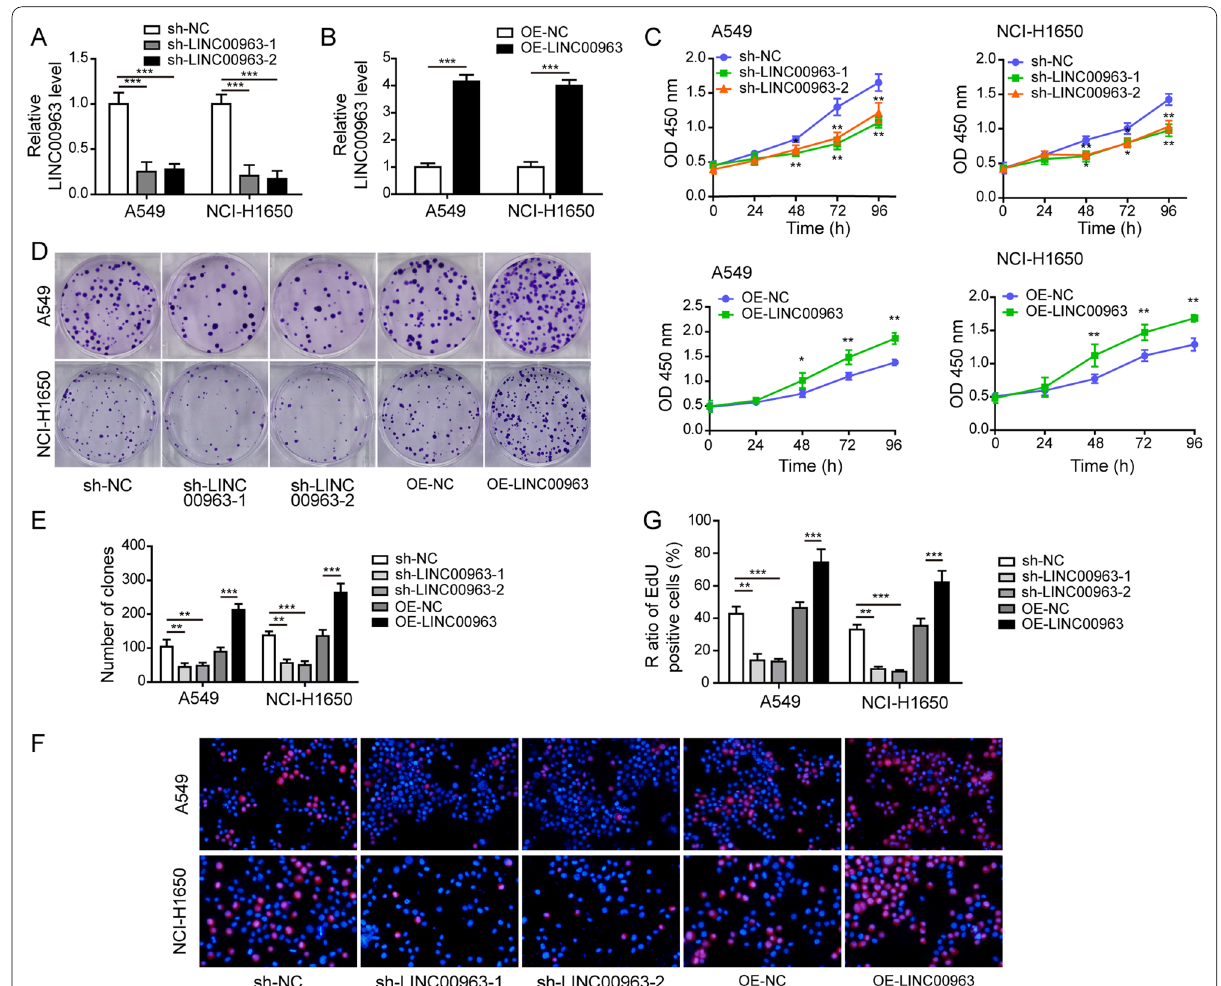
Fig. 2 LINC00963 sufficiently induced the proliferation of LUAD cells. A549 and NCI-H1650 cells stably expressed two distinct shRNA targeting LINC00963 or overexpressed LINC00963. A , B RT-qPCR assay examined LINC00963 expression in indicated cells with LINC00963 overexpression or silence. Proliferation ( C ), long-term proliferation ( D , E ), and short-term proliferation ( F , G ) of indicated cells were determined using CCK-8, colony formation, and EdU assays, respectively. * P < 0.05, ** P < 0.01 and *** P <